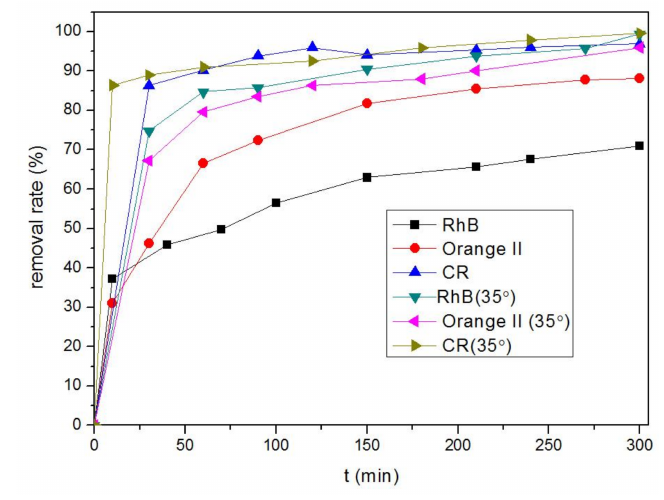
Figure 6. Removal rates of Rhodamine B (RhB), Orange II, and Congo red (CR) by